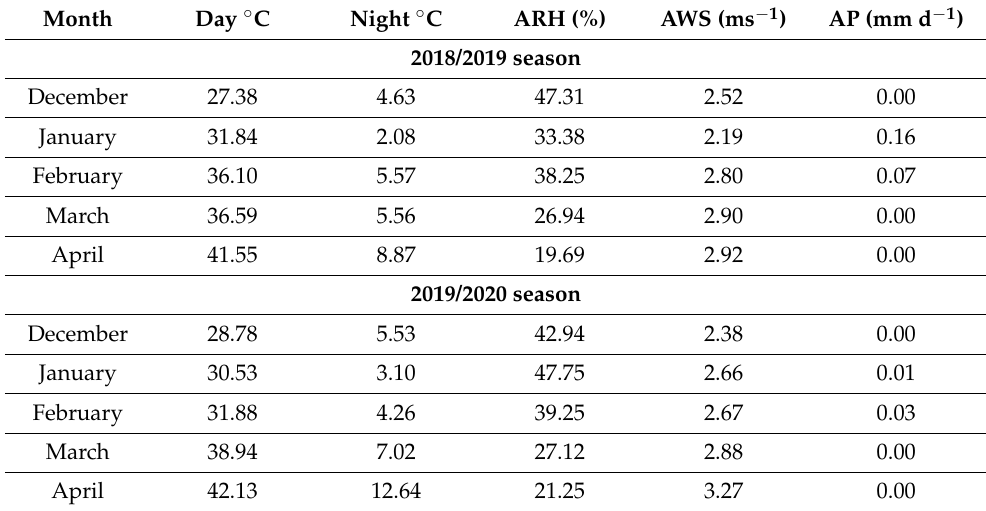
Table 1. The weather data from the Aswan region in Egypt during wheat growing